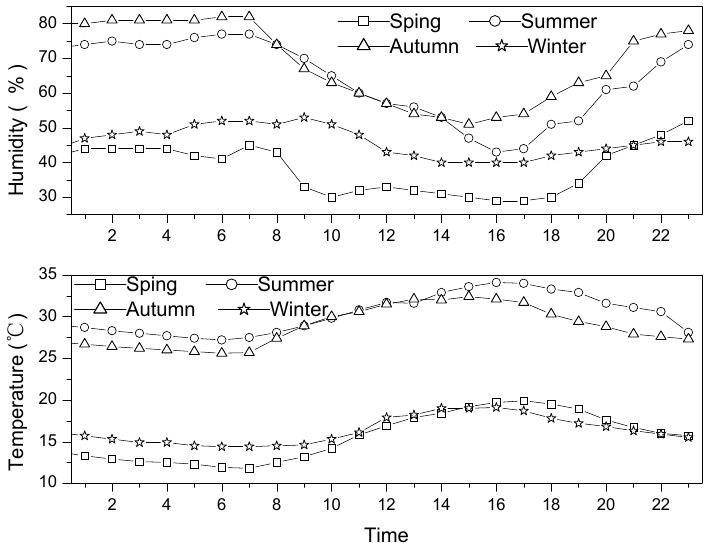
Figure 2. The mean temperature and humidity in four